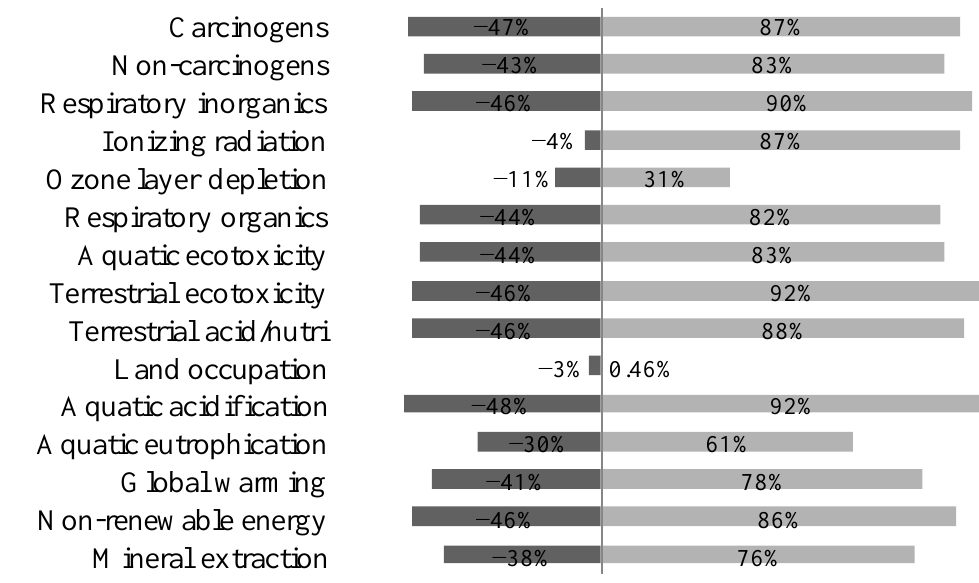
Figure 6. Impacts of NiO fraction in the metal